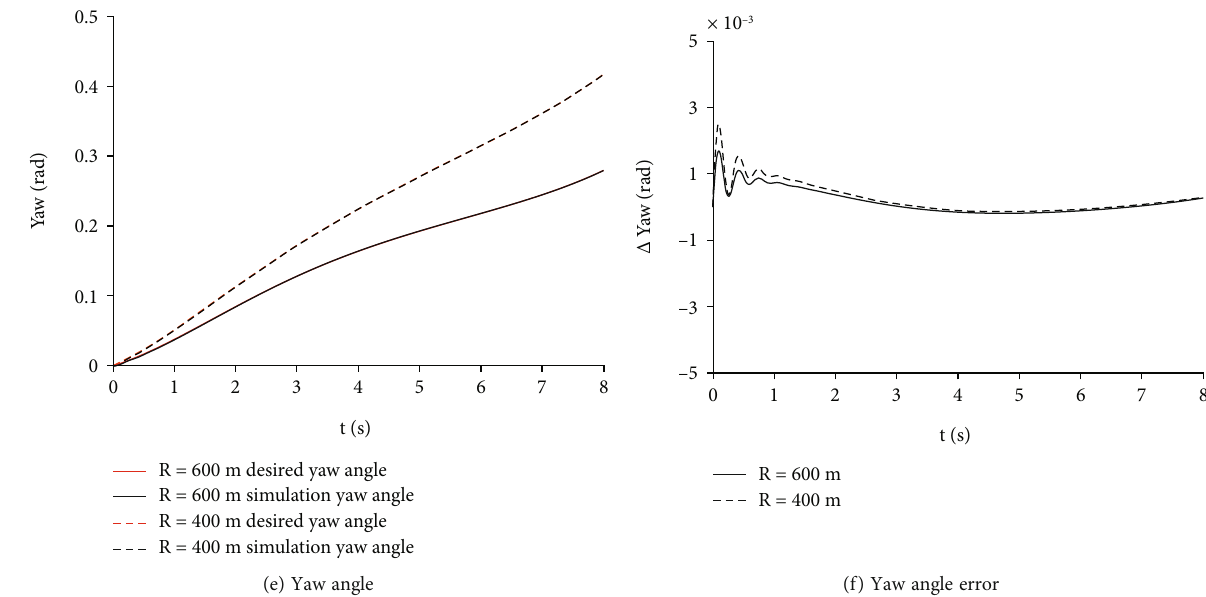
Figure 5: Vehicles lane-changing from outside to inside with di ff erent curvatures.